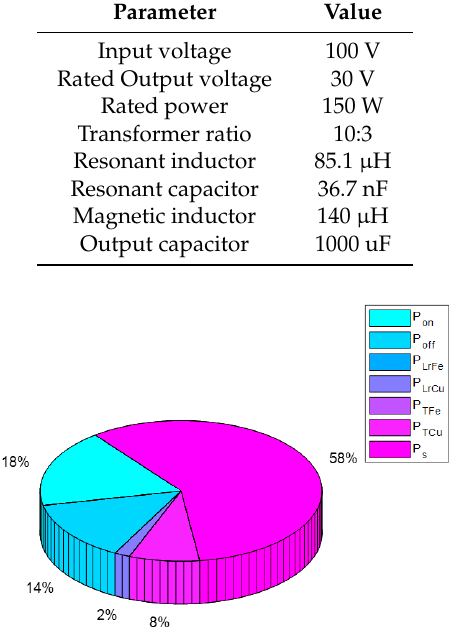
Figure 16. Gain curve comparison. FHA = fundamental harmonic approximation.